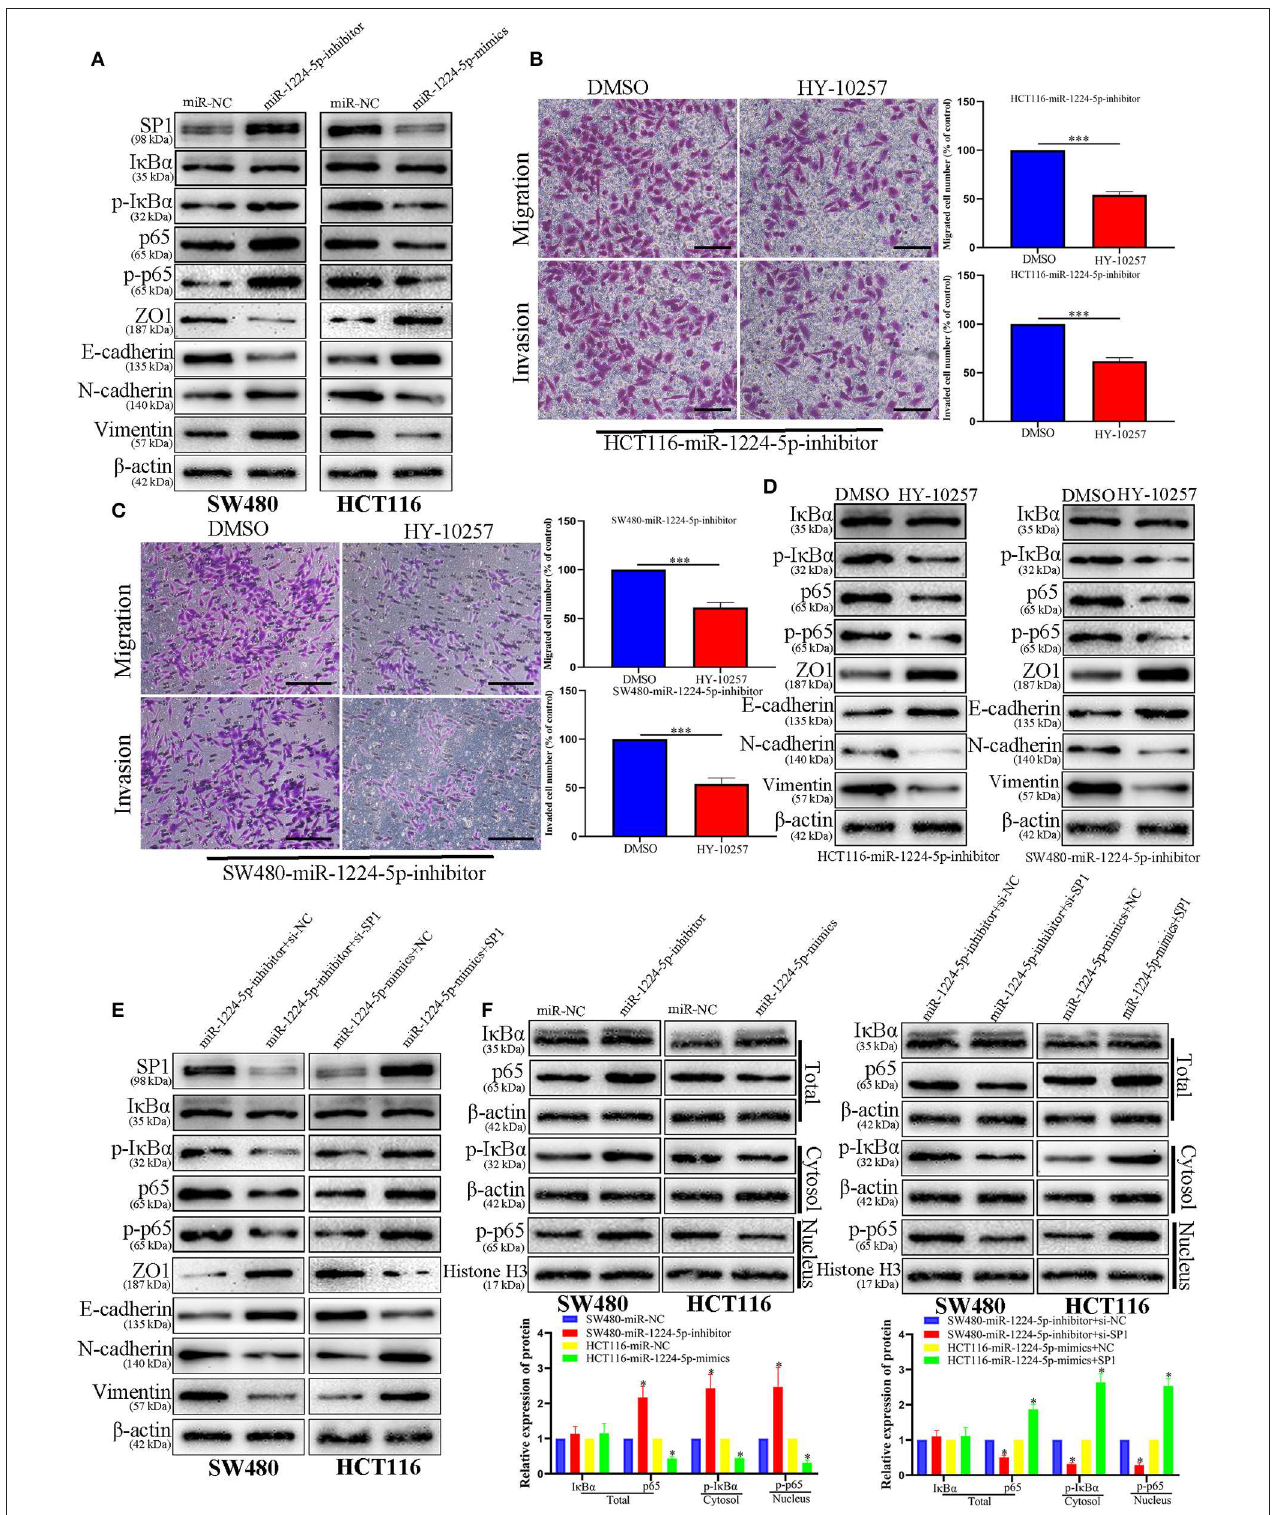
FIGURE 8 | NF- κ B signaling is essential for the biological function of miR-1224-5p in CRC. (A) SW480 and HCT116 cells that were transfected with corresponding miRNA lentivirus were subjected to immunoblotting for SP1, I κ B α , phosphorylated I κ B α , p65, phosphorylated p65, and EMT. (B,C) NF- κ B inhibitor HY-10257